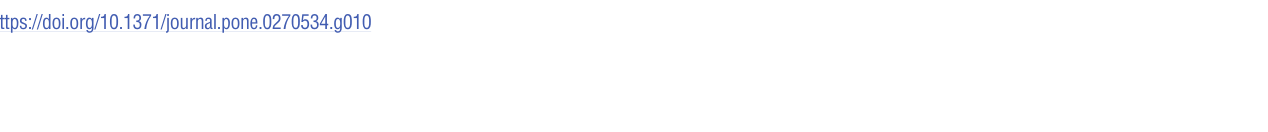
PLOS ONE | https://doi.org/10.1371/journal.pone.0270534 July 22,